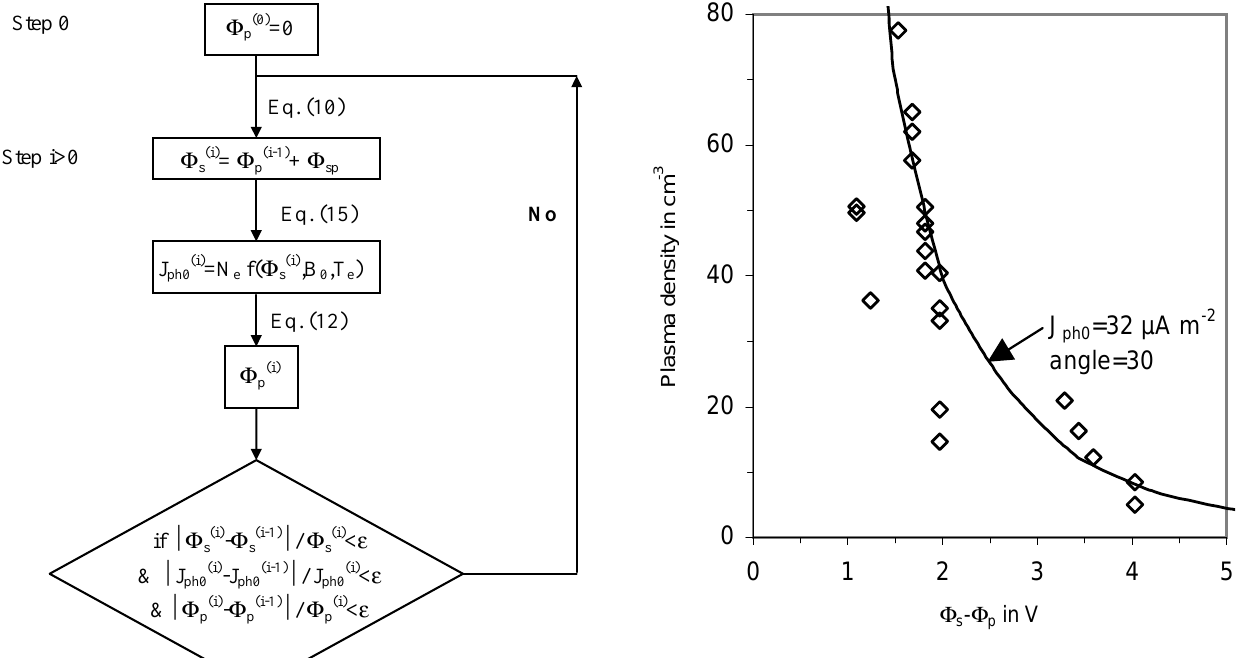
Fig. 11. Results of diagnostic measurements. The diamonds show the measurements of 8 sp and N e inferred from the IESP and POL- RAD experiments, respectively. The curve corresponds to a fitted N e (8 sp ) relation for T e = 1eV, B 0 = 1 µ T, α = 30 ◦ , and by assuming a value of the photoemission rate J ph 0 = 32 µ Am − 2